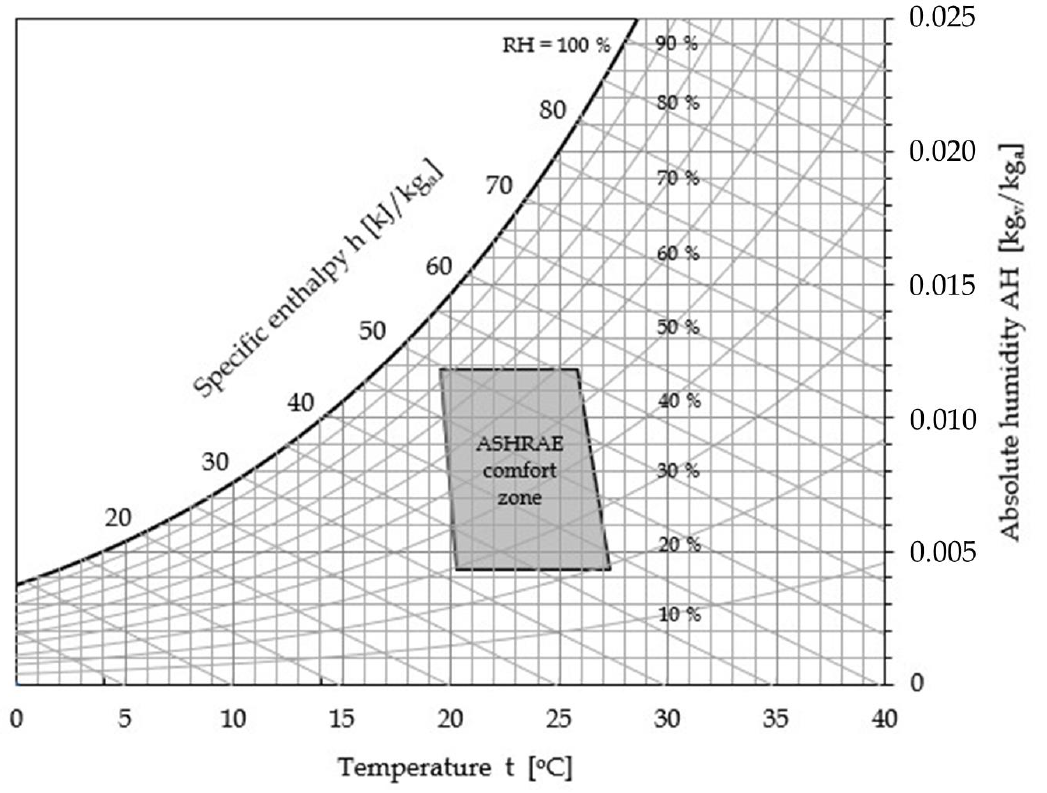
Figure 1. Conventional domestic and office-like comfort zone based on ASHRAE [13].